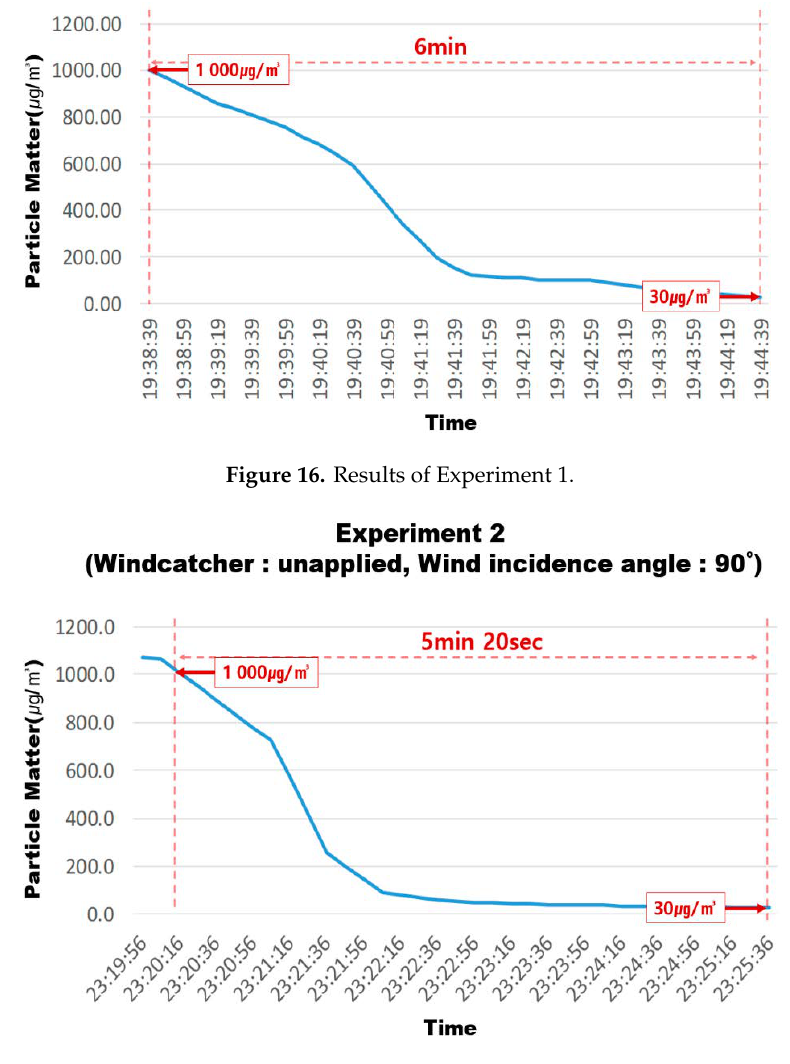
Figure 17. Results of Experiment 2.